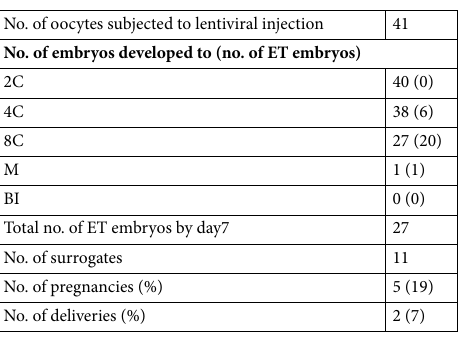
Table 1. Summary of production of founder (F0) transgenic marmosets. ET; embryo transplantation, 2C; 2-cell stage embryo, 4C; 4-cell stage embryo, M; morula, Bl; Blastocyst. All healthy embryos developed beyond the 4-cell stage were transplanted to surrogate